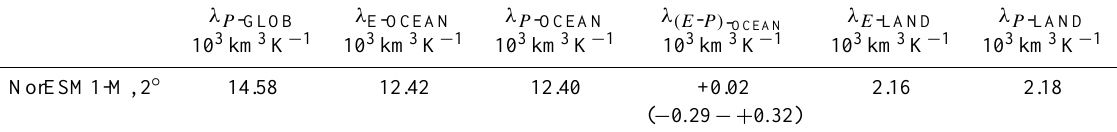
Table 3. Global gross feedback response ( λ X ) in parameters ( X ) characterising the hydro-climate, as determined by linear regression of model simulated annual change ( 1X ) with respect to the corresponding annual surface air temperature change ( 1T ) after abrupt 4 × CO 2 . X is an- nual amounts of evaporation ( E ), precipitation ( P ), or the difference ( E - P ) accumulated globally, from oceans, or from land (10 3 km 3 yr − 1 ). λ P - GLOB λ E - OCEAN